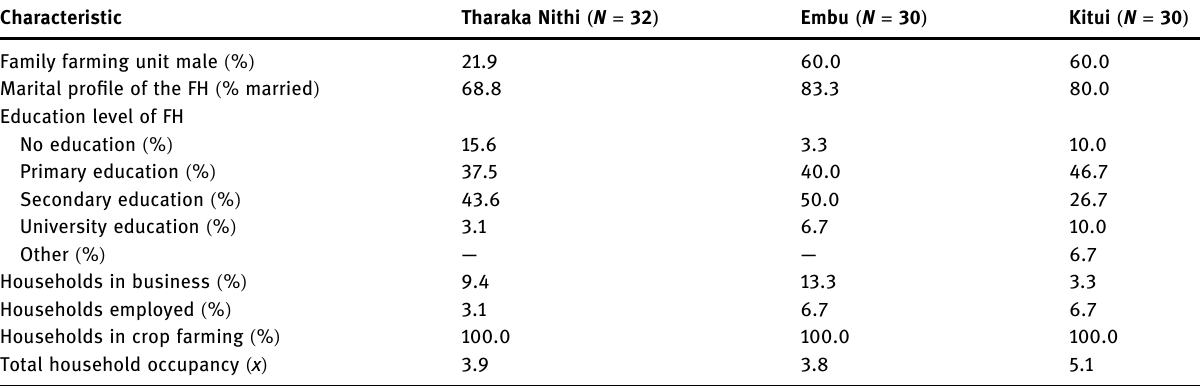
Table 3: Socio - economic factors a ff ecting biodiversity across the selected counties Characteristic